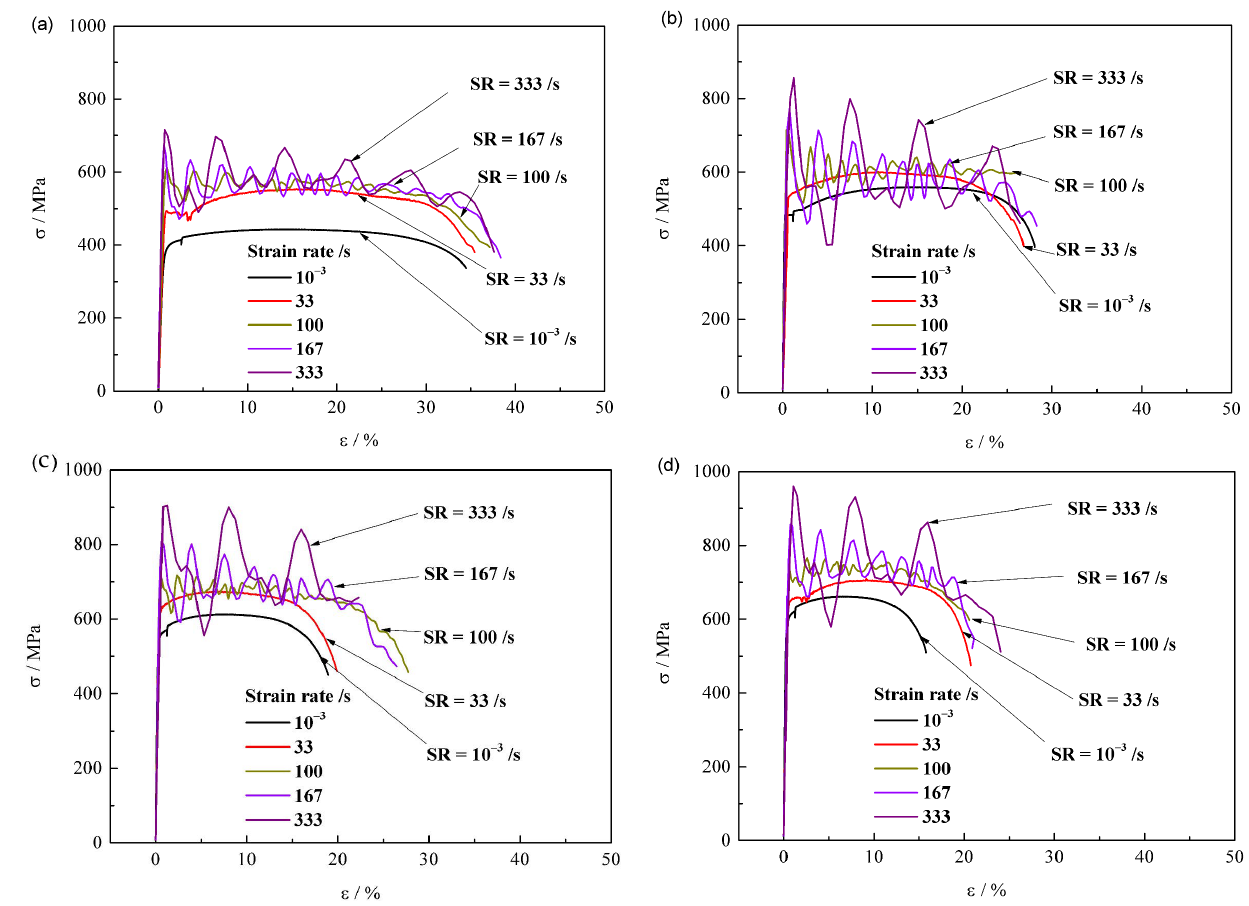
Figure 9. Stress-strain curves along transverse direction for specimens ( a ) Q380, ( b ) Q420, ( c ) Q460 and ( d ) Q500 at different strain rates.